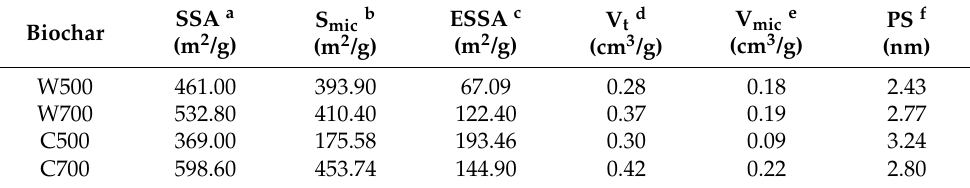
Table 2. BET analysis of biochars.